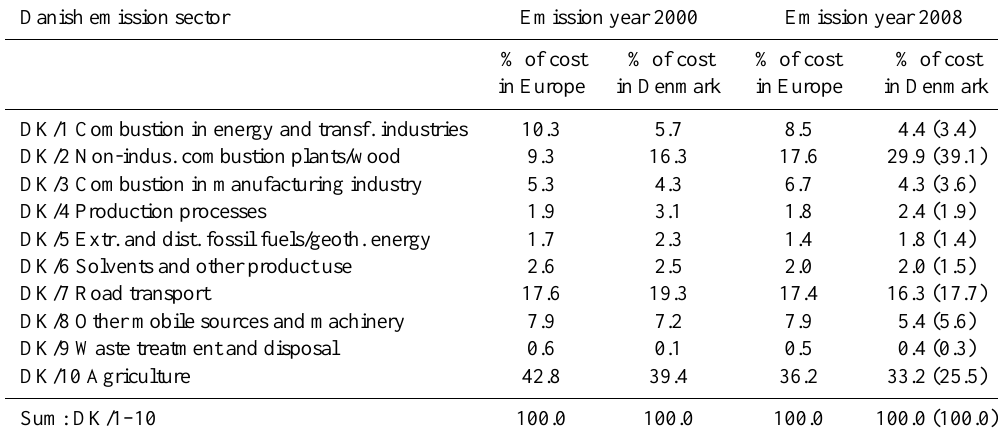
Table 6. Contributions in % from Danish anthropogenic emission sectors to the total health-related external costs in Europe and Denmark for two different emission years (2000 and 2008). The numbers in parentheses represent a sensitivity study in order to assess the effects of assigning different toxicity to primary emitted and secondary formed particles with factors of 1.3 and 0.7 respectively according to NEEDS